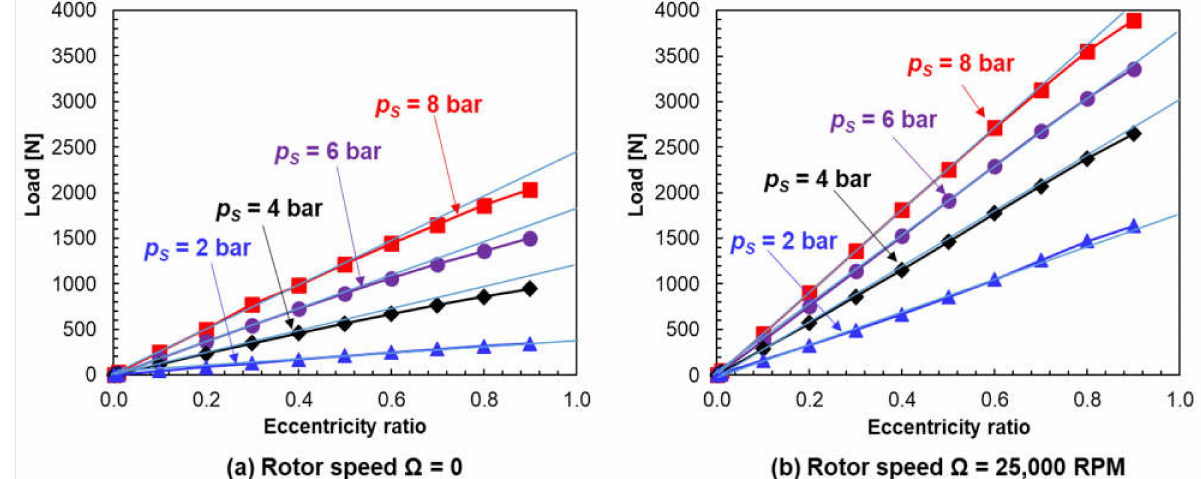
Figure 8. FE model of PGB load ( W ) vs. journal eccentricity ratio ( e / c ) at 0 rpm and 25 krpm shaft speed. Air supply pressure p S = 2, 4, 6, and 8 bar; ( a ) Load at 0 rpm; ( b ) Load at 25 krpm. PGB clearance c = 0.010 mm. (Light colored) straight lines represent approximate load capacity derived from the exact solution at e =